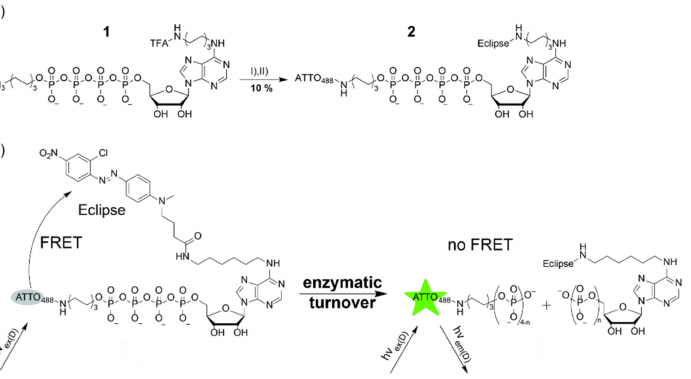
Figure 1. ( a ) Synthesis of the Ap4 analog 2 . Conditions: ( I ) 1. aqueous ammonia (7.5%), 5 h at RT. 2. Eclipse-NHS 1 M